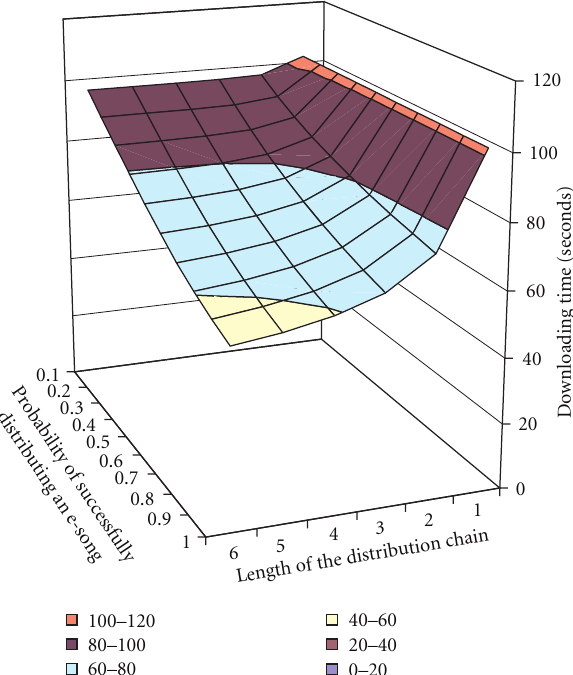
Figure 6: Average downloading time in a multichannel distribu- tion strategy by coupling the Bluetooth personal communication technology with 3G cellphone